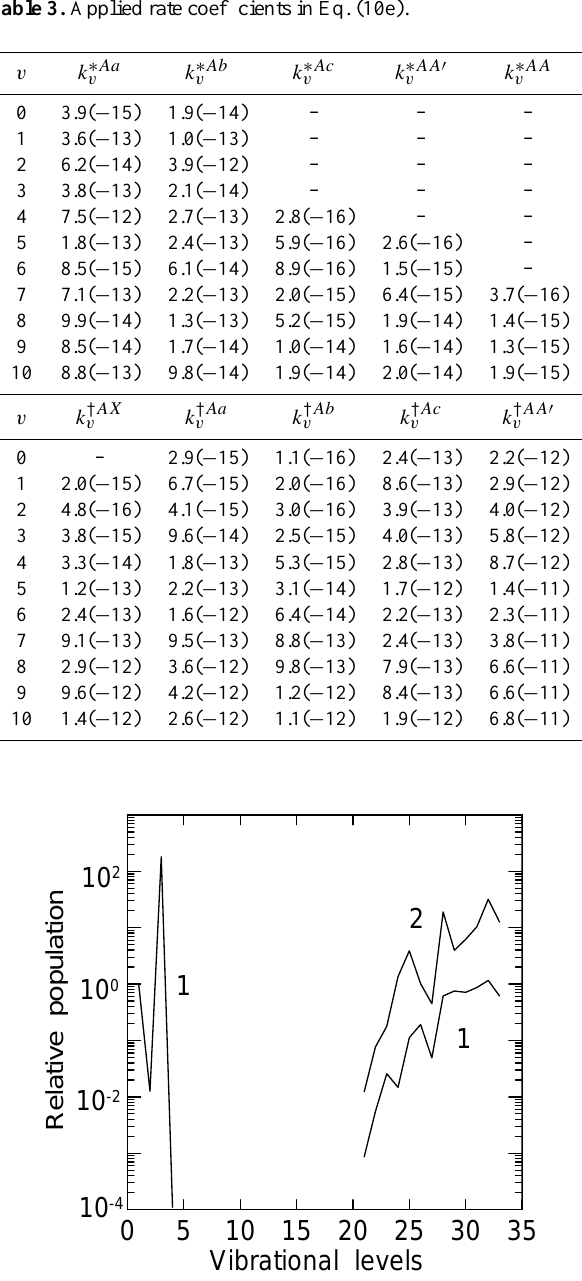
Table 3. Applied rate coefficients in Eq. (10e).